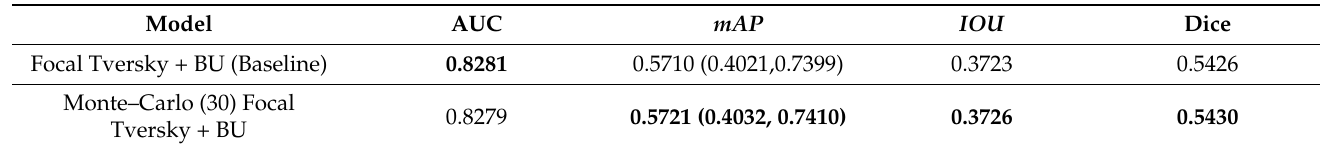
Table 3. Performance comparison using the baseline predictions and prediction averaging with 30 MC forward passes. Bold numerical values denote superior performance.